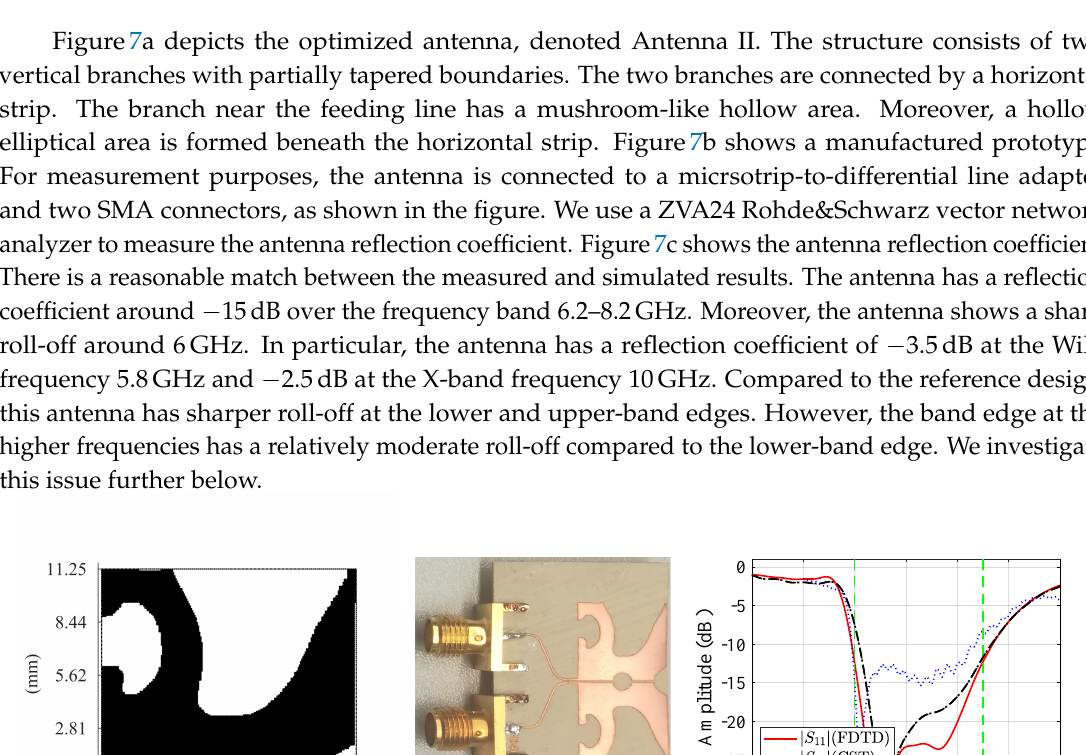
Figure 6. Development of the physical design of Antenna II over iterations 1, 34, 68, and 129. Black color indicates a good conductor and white color indicates a good dielectric.